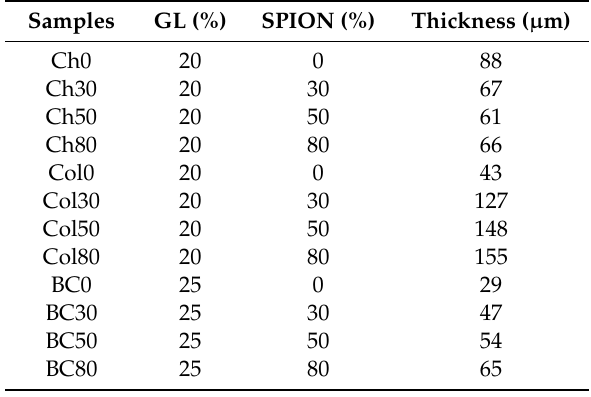
Figure 1. Representative illustration of biocomposite films preparation. Table 1. Composition and thickness of prepared magneto-dielectric biocomposite films.